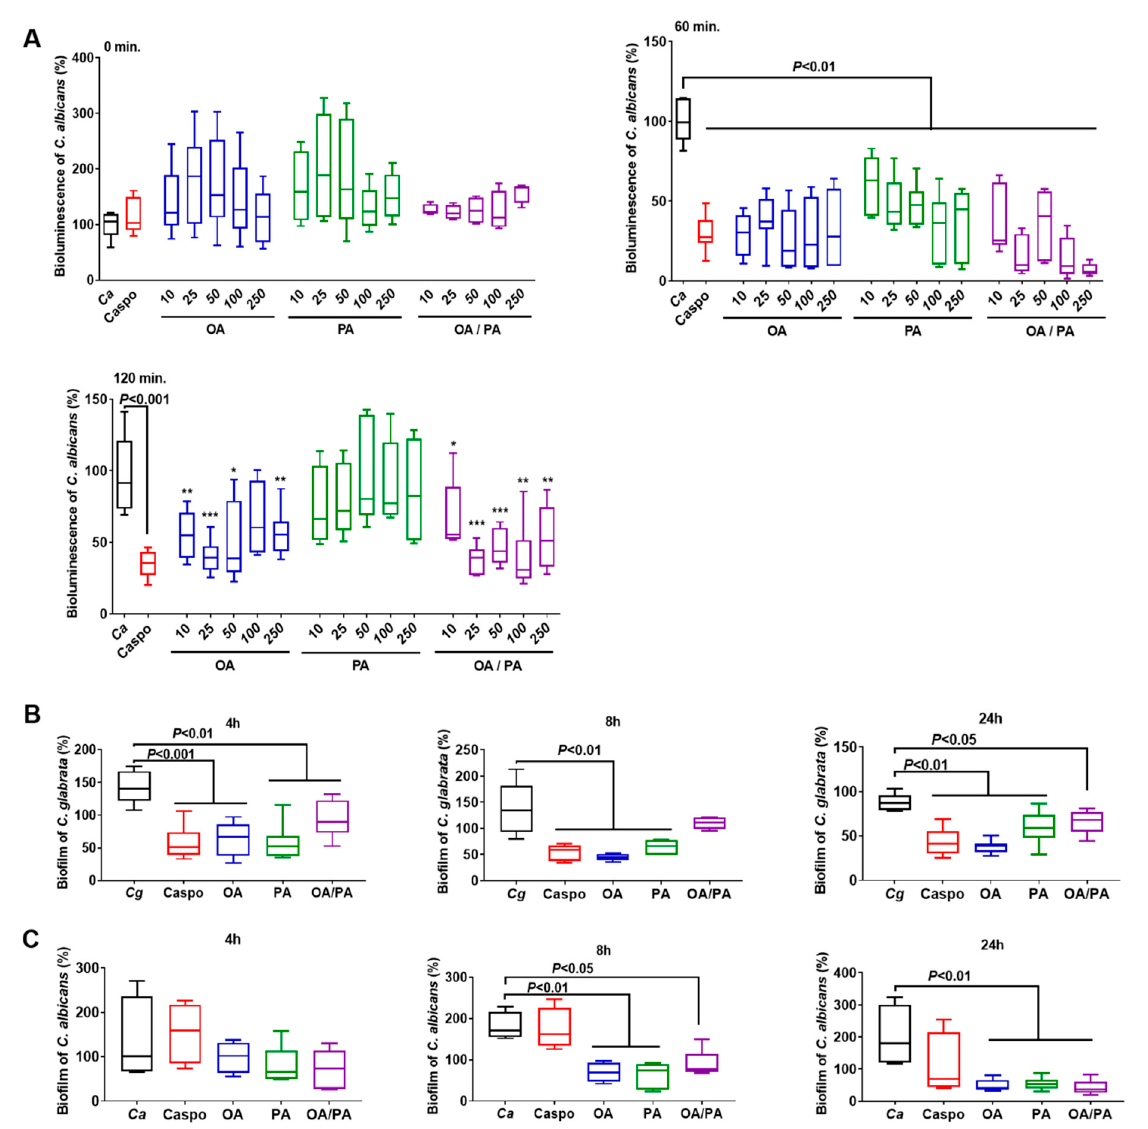
Figure 6. Effect of fatty acids on Candida spp. ( A ) Bioluminescence of C. albicans treated with OA, PA, or OA/PA at a concentration of 10, 25, 50, 100, or 250 µg/mL after 0, 60, and 120 min. * p < 0.05 OA, PA, or OA/PA vs. C. albicans ; ** p < 0.01 OA, PA, or OA/PA vs. C. albicans ; *** p < 0.001 OA, PA, or OA/PA vs. C. albicans . ( B ) Biofilm of C. glabrata challenged with OA, PA, or OA/PA at a concentration of 25 µg/mL after 4, 8, and 24 h. ( C ) Biofilm of C. albicans challenged with OA, PA, or OA/PA at a concentration of 25 µg/mL after 4, 8, and 24 h. C. glabrata ( Cg ) and C. albicans (Ca ): control groups; Caspo: standard control, challenge with caspofungin; OA, PA, OA/PA: C. glabrata or C. albicans challenged with OA, PA, or FAs (OA/PA), respectively. The results were obtained from three independent experiments.